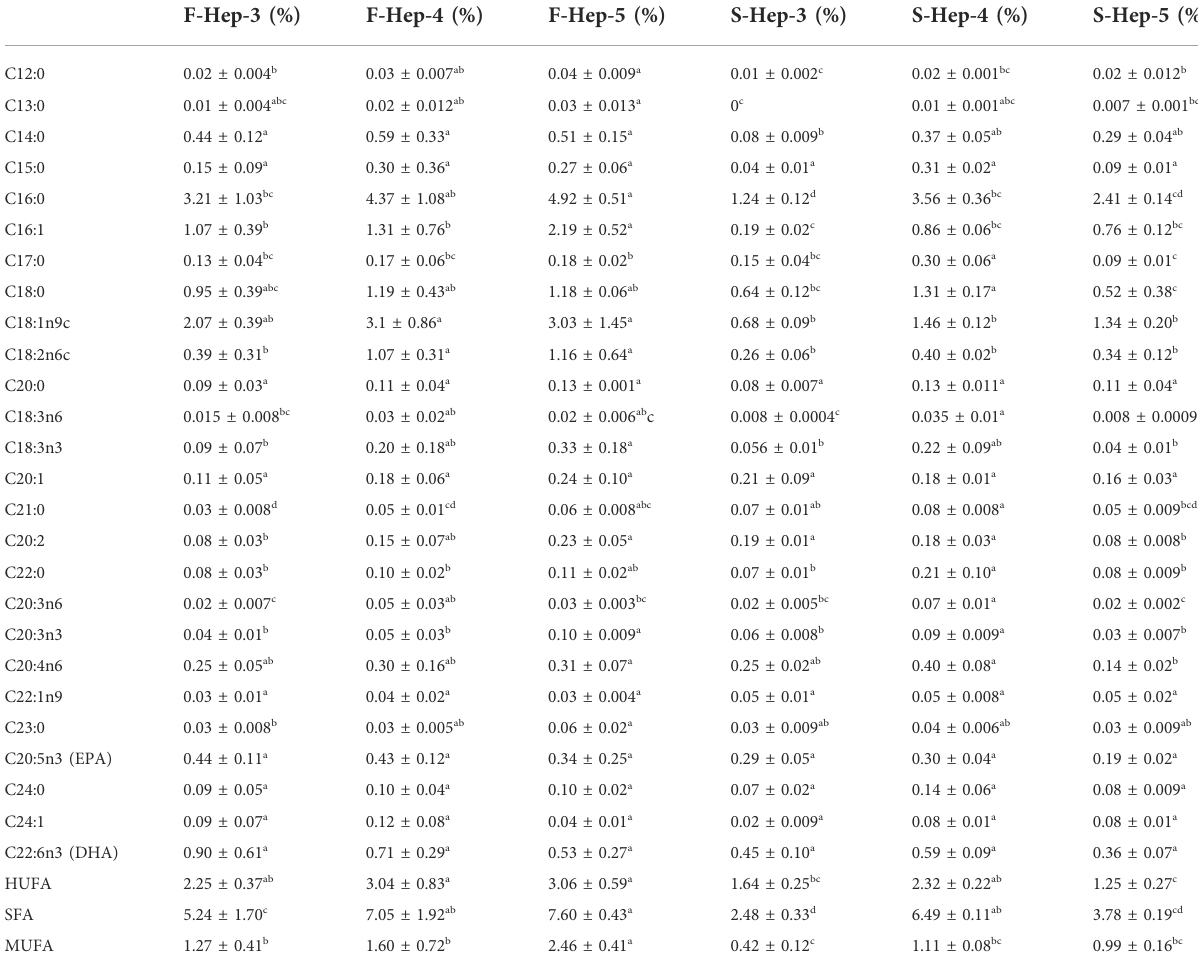
TABLE 9 Pro fi le of fatty acids in female Scylla paramamosain hepatopancreas during the two vitellogenesis periods. F-Hep-3